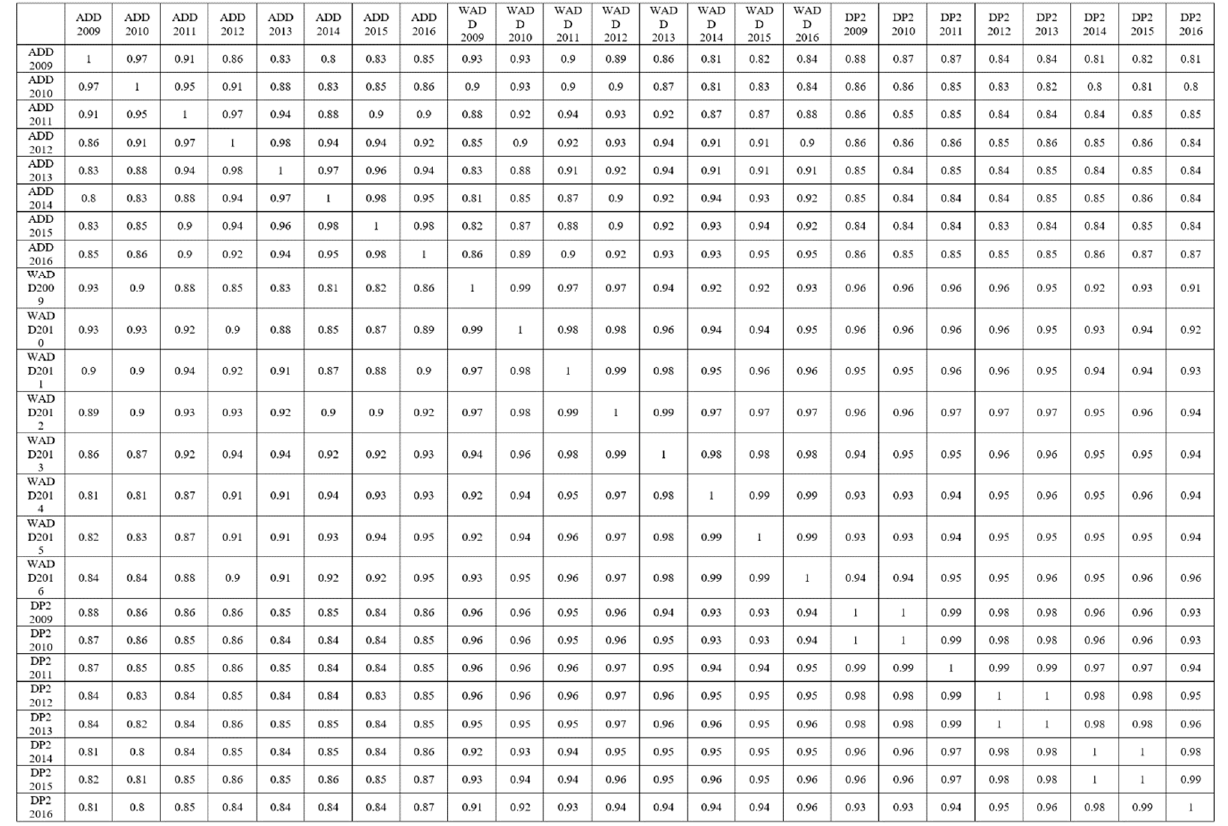
Figure A1. Appendix: Spearman correlation matrix.